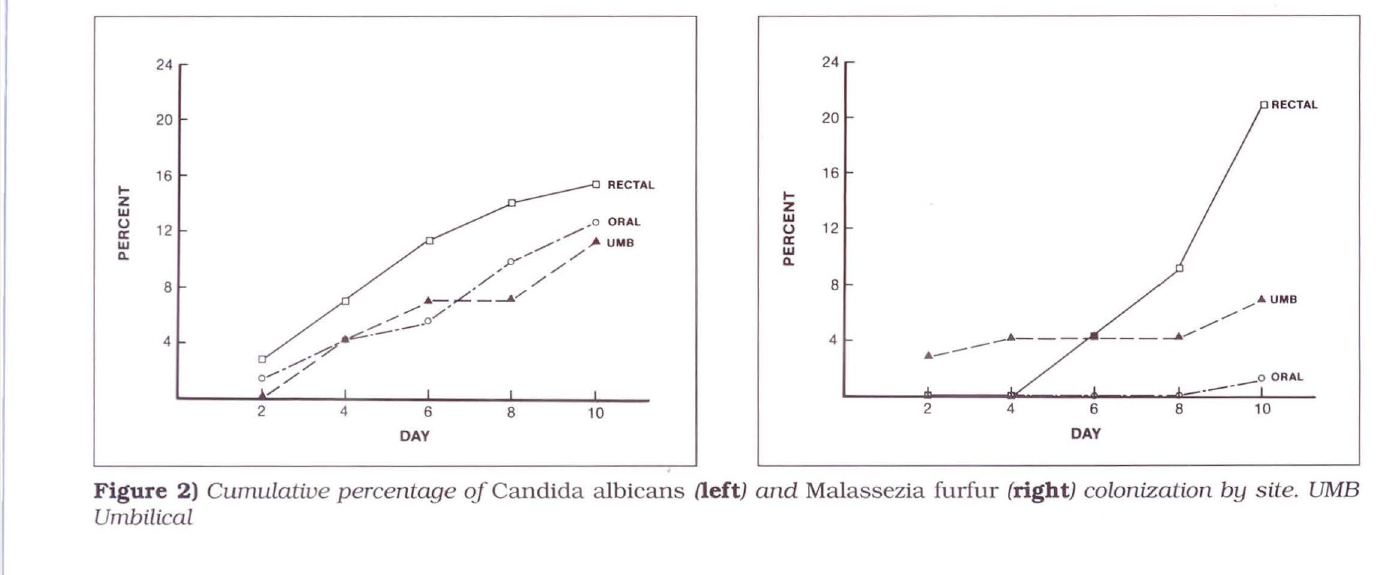
Figure 2) Cumulative percentage of Candida albicans (left) and Malassezia furfur (right) colonization by site. UMB